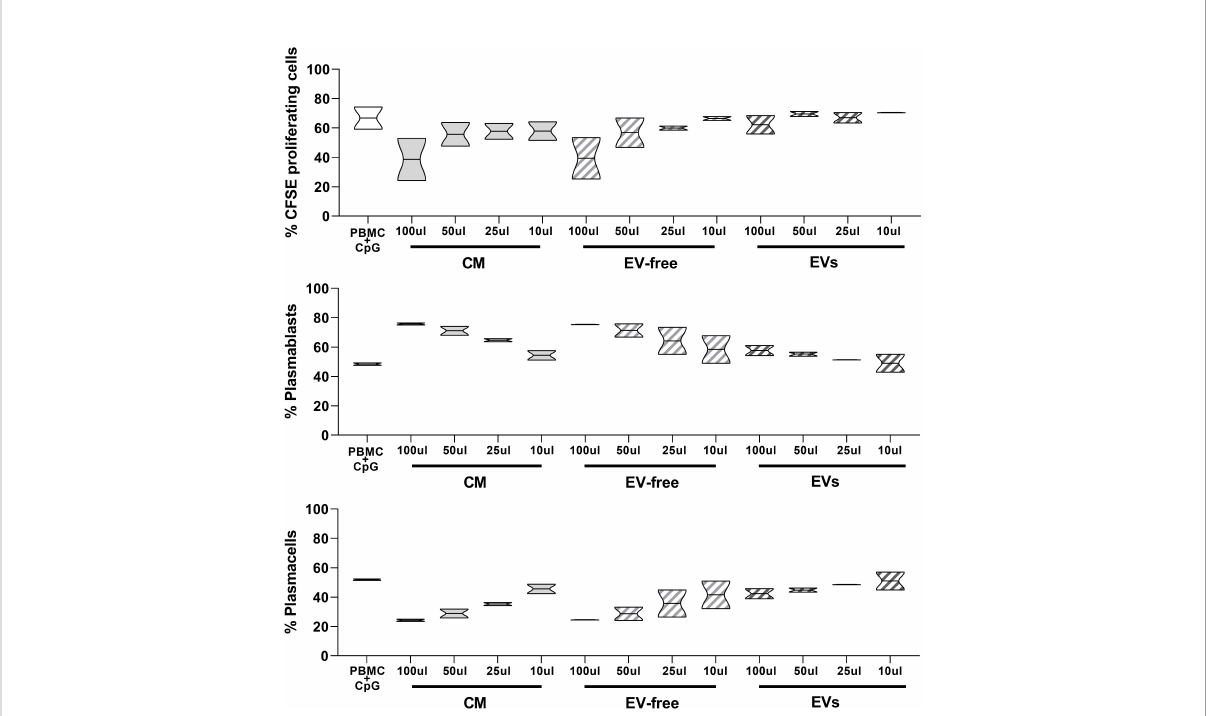
FIGURE 5 Effects of hAMSC-CM and its fractions (EV-free and EVs) on B lymphocyte proliferation and maturation. Allogeneic PBMCs (1×105) were stimulated with CpG in the presence of 100, 50, 25, or 10 µl of hAMSC-CM or with the same volume of the EV-free or EV fractions. B-cell proliferation was measured by the analysis of CFSE dilution and calculated as percentage of CD19+-proliferating cells. The impact that hAMSC- CM and its fractions have on B lymphocyte differentiation was evaluated analyzing the total amount of plasmablasts (CD19 + CD27 hi CD38 hi CD138 - ) and plasma cells (CD19 + CD27 hi CD38 hi CD138 + ) obtained from the different culture conditions and compared with the control condition. Results are presented as a percentage of expression and are shown as violin plots with median (thick line) and 25th and 75th quartiles versus control PBMC+CpG, N ≥ 2 individual experiments.